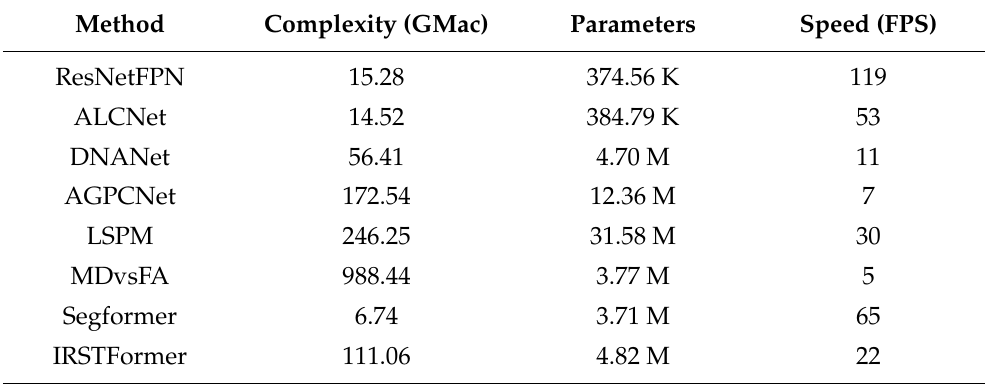
Table 2. The computational complexity, the number of parameters, and the processing speed of different networks.